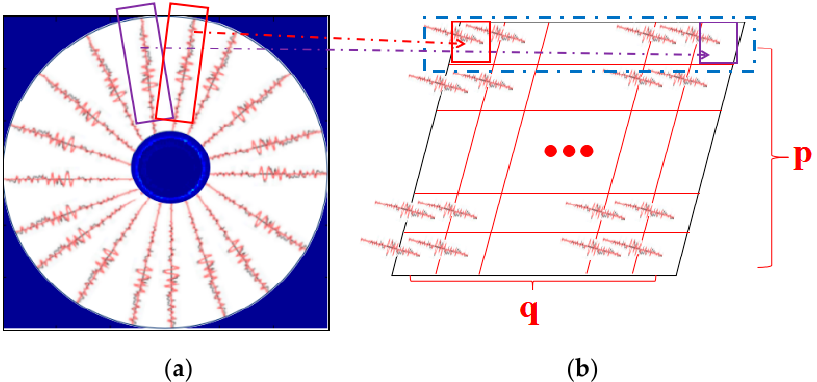
Figure 5. Acoustic wave scanning data and its matrix processing. ( a ) Horizontal section acoustic wave scanning data, ( b ) schematic diagram of matrix processing.